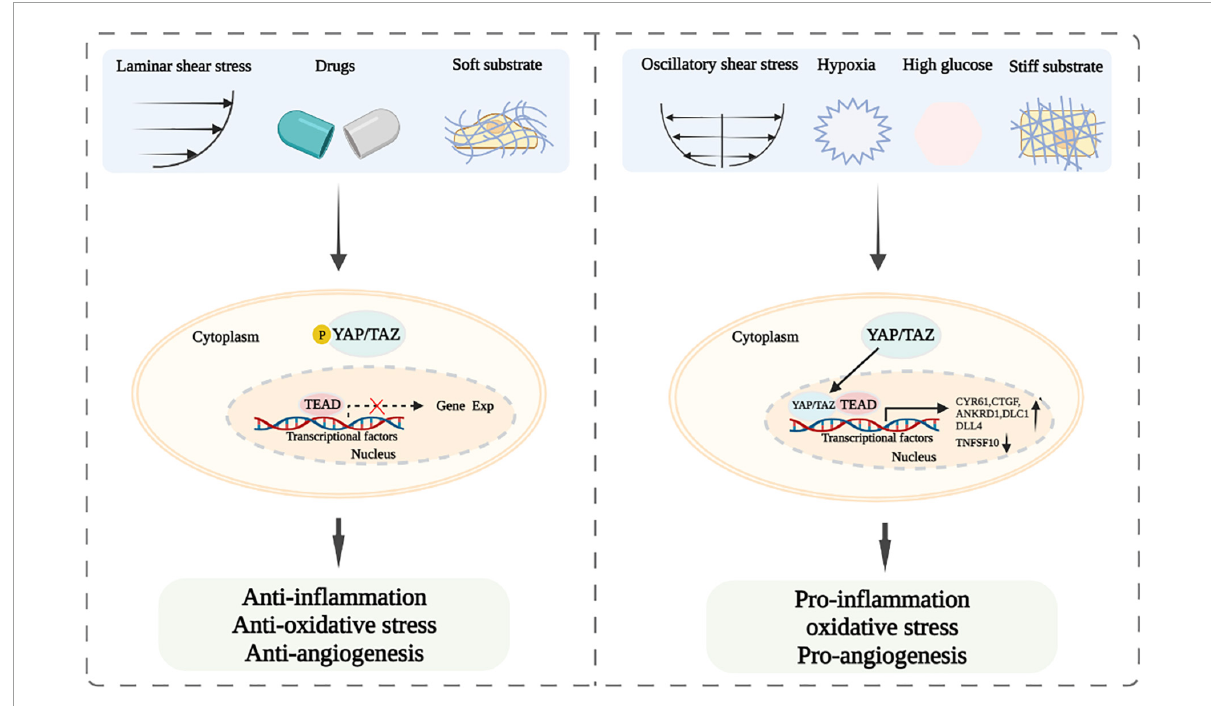
FIGURE2 Schematic diagram of YAP/TAZ signaling and their modulation of endothelial functions after exposing to laminar and oscillatory shear stress, different drugs, soft and hard substrate, hypoxia or high glucose.